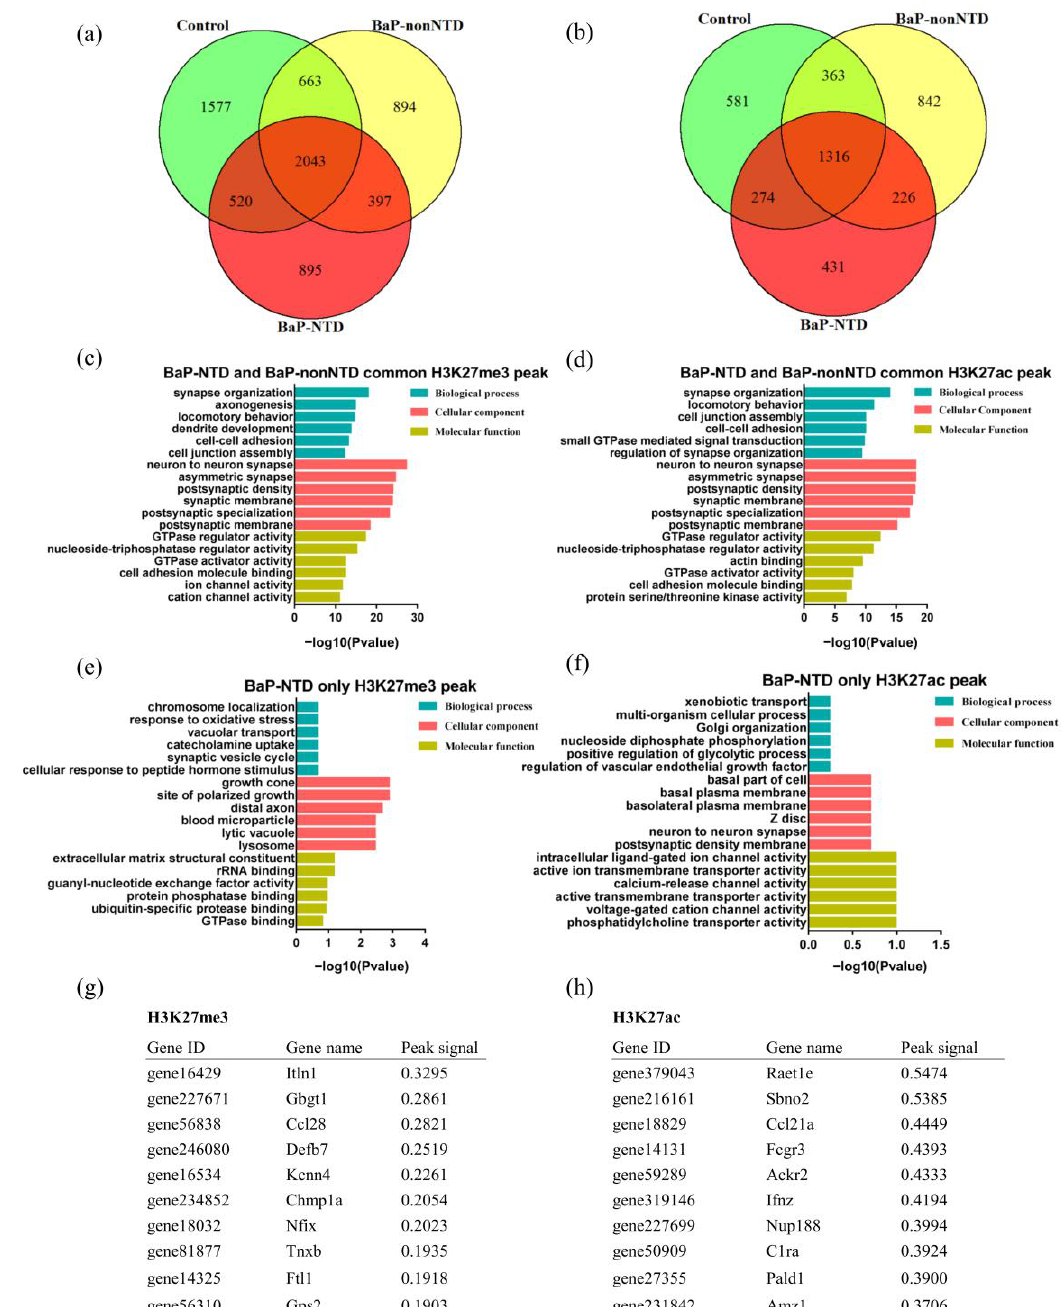
Figure 2. Common and unique H3K27me3 and H3K27ac peaks in E9.5 mouse embryos with and without NTDs. Venn diagram showing the overlap of H3K27me3 ( a ) and H3K27ac ( b ) binding genes. Top six GO biological processes, cellular components, and molecular functions enriched from common H3K27me3 ( c ) and H3K27ac ( d ) binding genes between BaP-nonNTD and BaP-NTD (ordered by significance level). Top six GO biological processes, cellular components, and molecular functions enriched from unique H3K27me3 ( e ) and H3K27ac ( f ) binding genes for BaP-NTD (ordered by significance level). The list of the top 10 unique BaP-NTD peak binding genes for H3K27me3 ( g ) and H3K27ac ( h ).